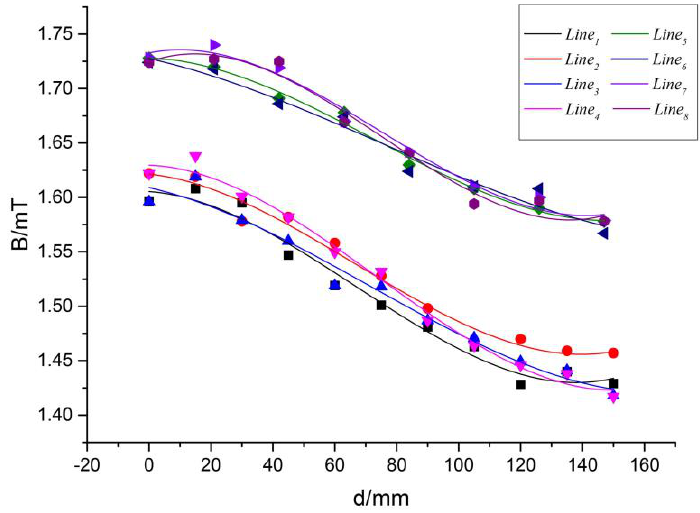
Figure 7. Fitting data of magnetic flux density in eight typical directions.